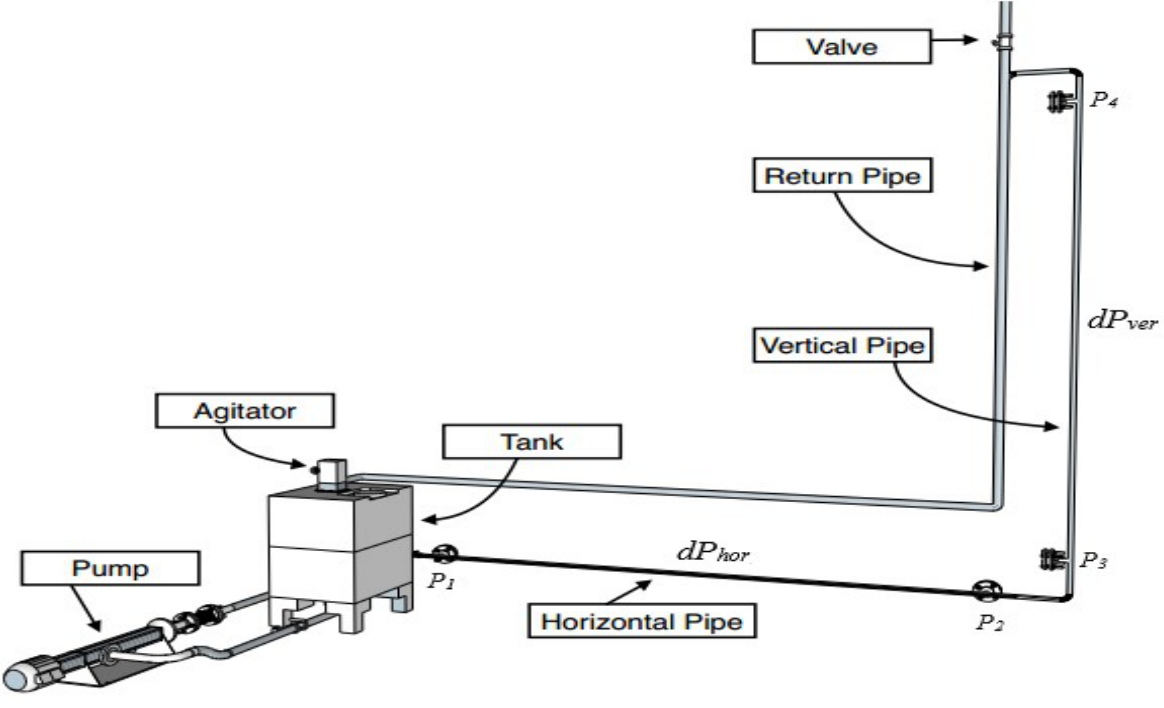
Figure 1: Simplified schematic of the instrumented standpipe